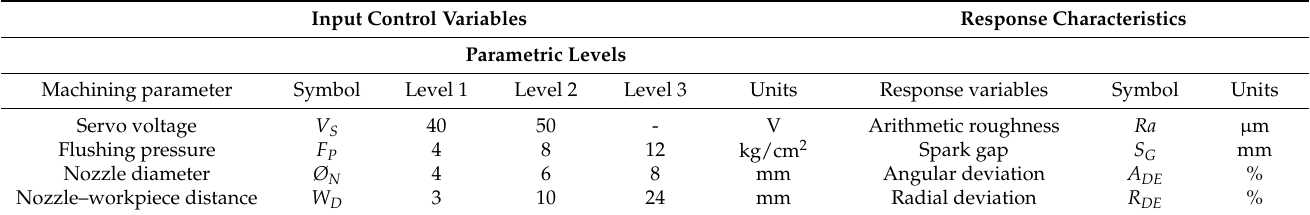
Table 2. Process control variables and response characteristics.